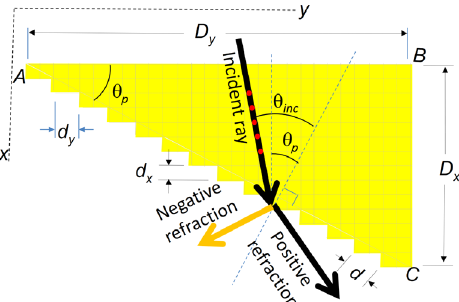
Fig. 1. Propagation through a cellular prism-shaped material with serrated hypotenuse. The red dots along the incident ray trajectory denote the intersection between the ray and the cell walls parallel to the y -axis where the phase is sampled to evaluate the phase velocity (see Sect. 3).